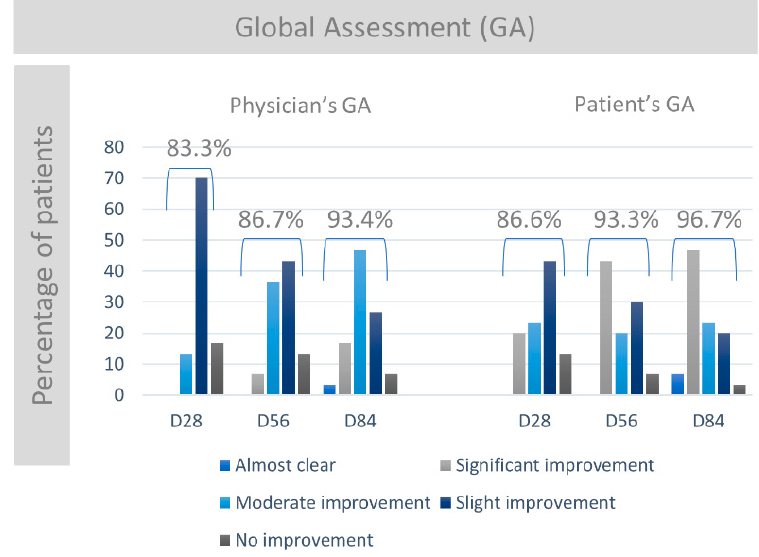
Figure 3. Percentage of subjects reporting different levels of response (almost clear, significant, moderate, slight or no improvement) determined both by Physician’s and by Patient’s Global Assessment at different times (D28, D56 and D84).